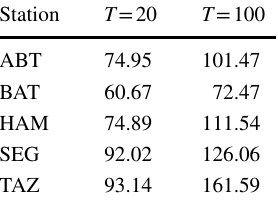
Table 6 Return levels for each